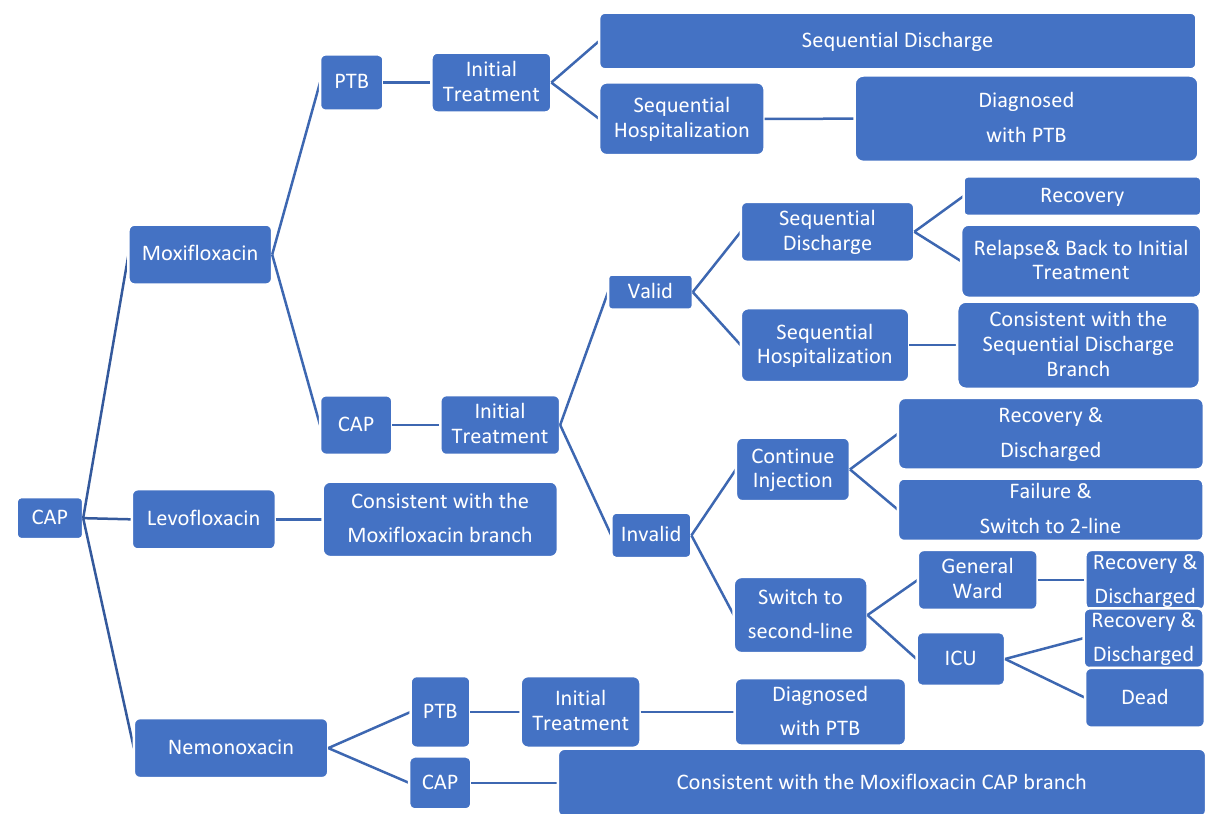
Figure 1. Model structure (PTB, pulmonary tuberculosis).